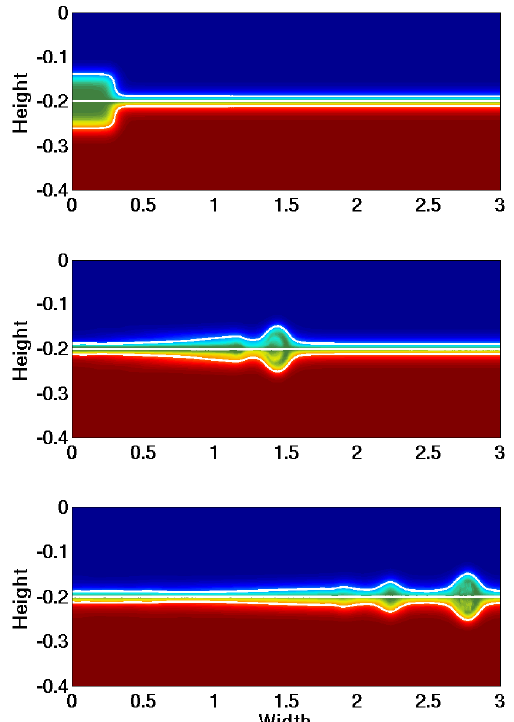
Fig. 3. Plot of the density evolution at times t = { 0 , 25 , 50 } s. Three isocontours of density highlight the location of the mode-2